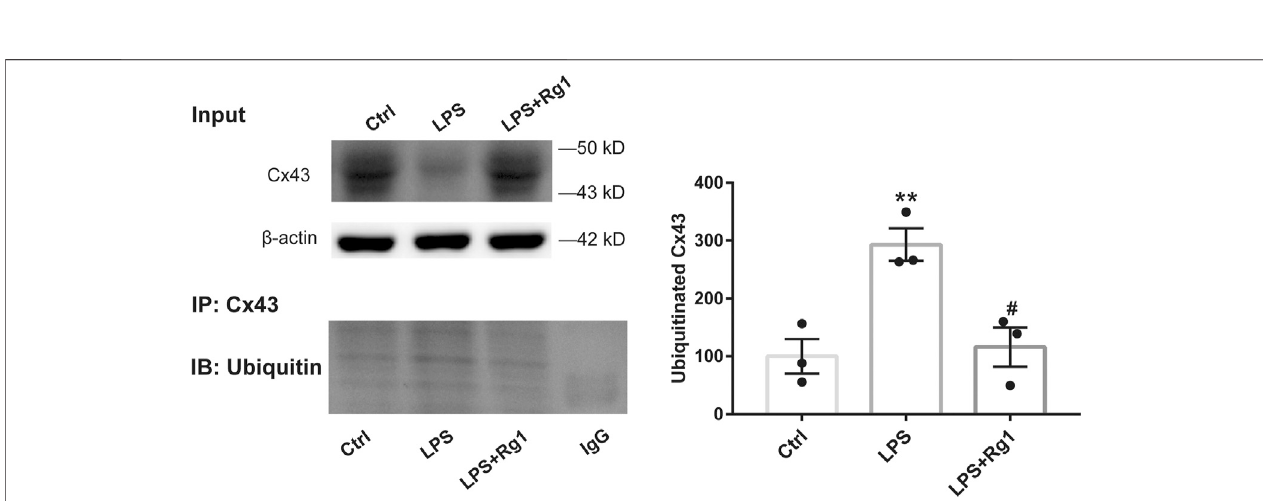
FIGURE8| Rg1suppresses theincreasedCx43 ubiquitindegradation inLPS-inducedglialcells. Thecell lysates weresubjectedtoimmunoprecipitation withanti- Cx43 antibody (IP: Cx43) or normal IgG. The resultant precipitates were then subjected to western blot using anti-ubiquitin antibody (IB: Ubiquitin). Quanti fi cation of the ubiquitinated Cx43 was expressed as percentages of the control values. n (cid:1) 3. ** p < 0.01, compared with the Ctrl group; # p < 0.01, compared with the LPS group.